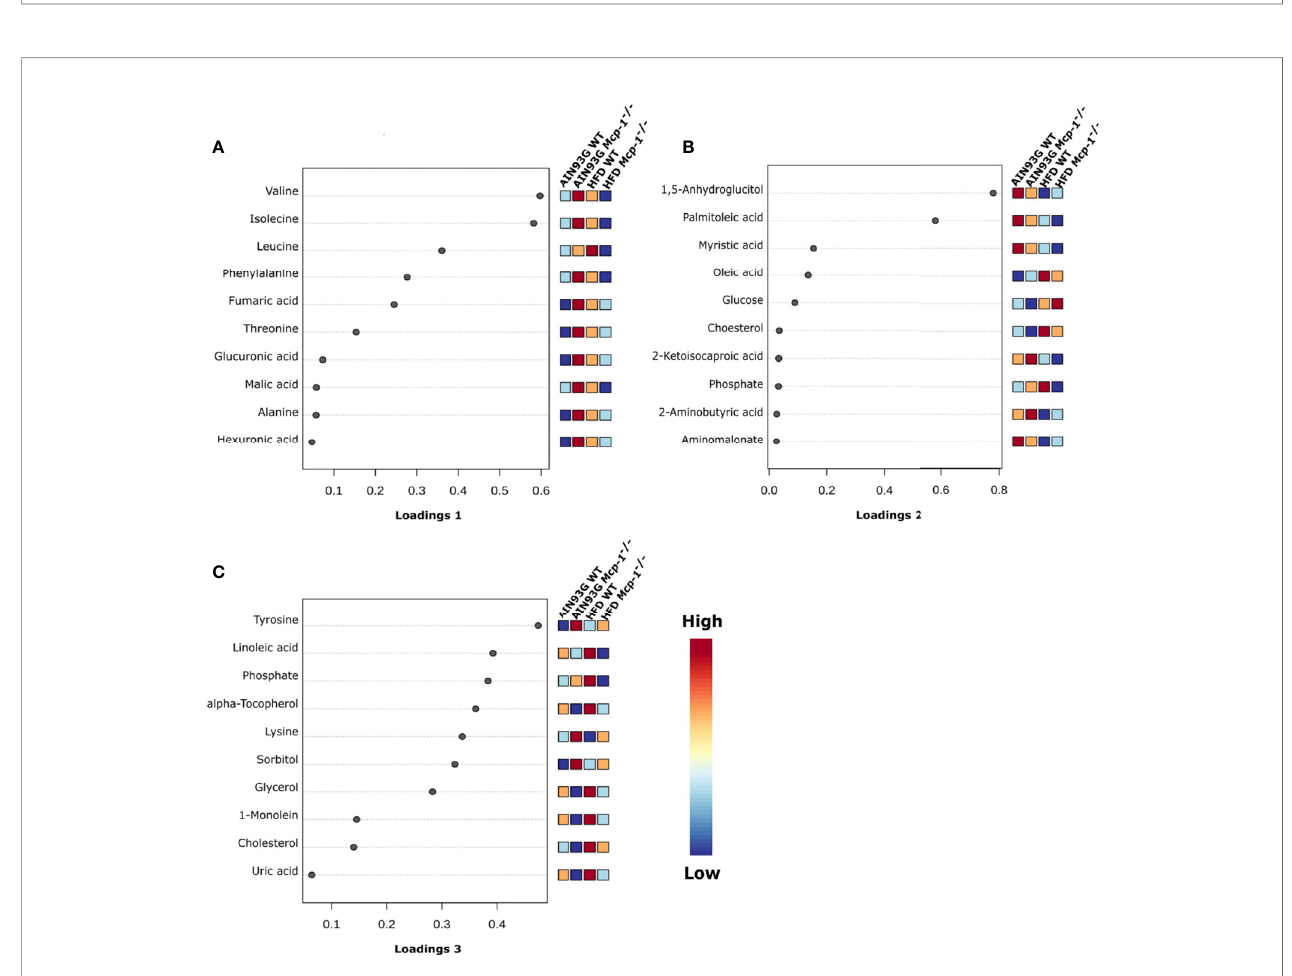
FIGURE 6 | Loadings plots of the 10 metabolites that are the most in fl uential in treatment separation among the four groups for components 1 (A) , 2 (B) , and 3 (C) (n = 10 per